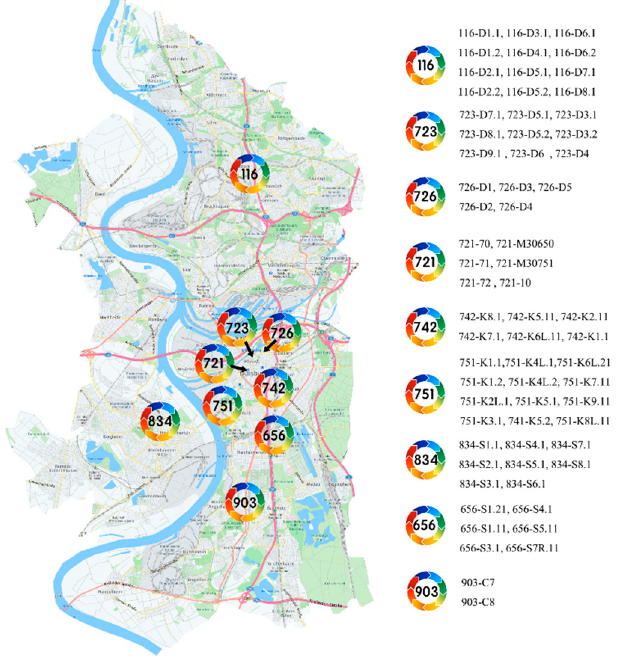
Figure 5. Selected road section for verification.